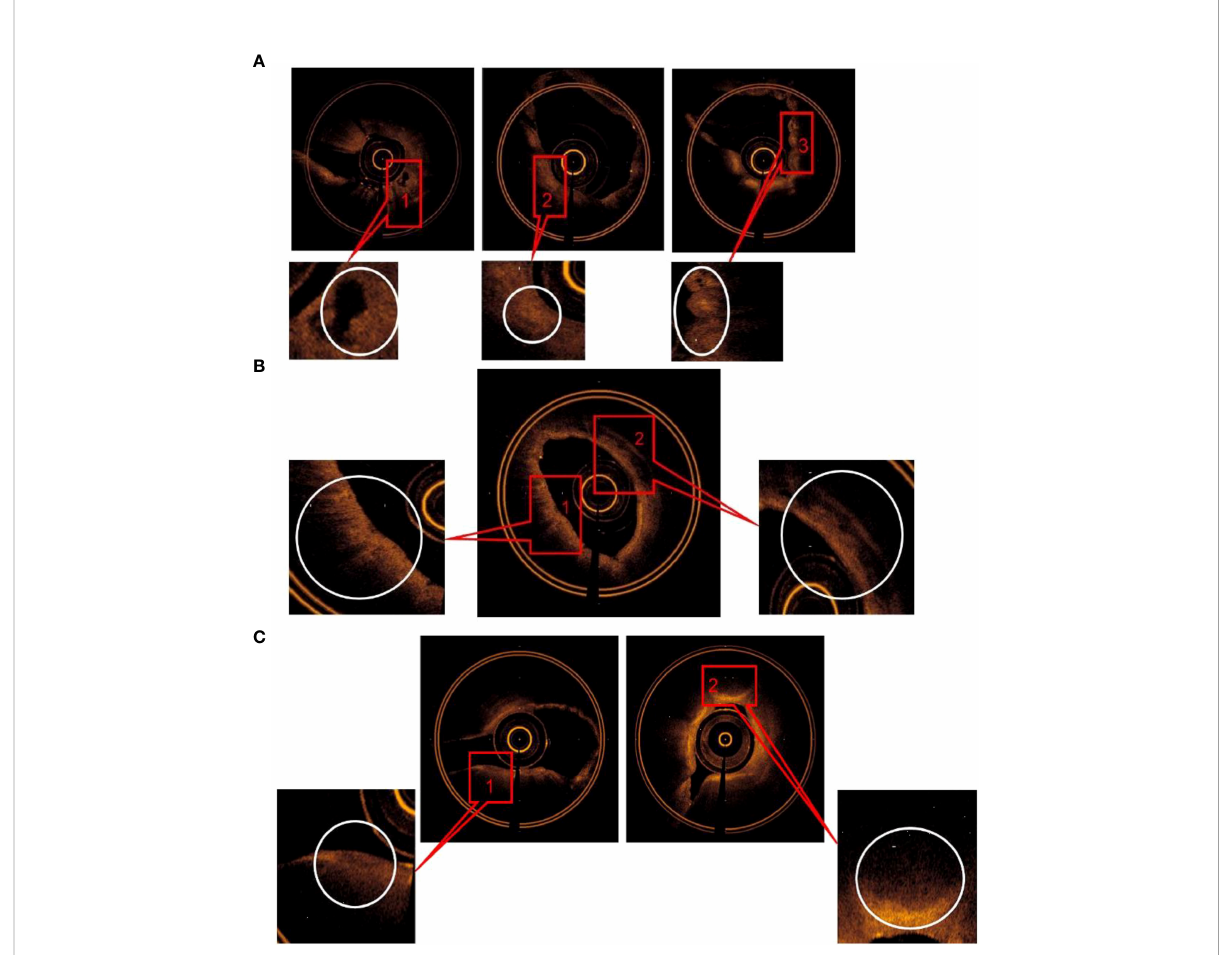
FIGURE 3 (A) The main OCT image features for predicting SCC: (1) “ Cyst-like ” structure, (2) “ round ” or irregularly shaped ” high signal nests, with or without low-density shadow, (3) Scaly protuberance of the epithelial layer, and a darkened gray level of the submucosa layer was found. (B) The main OCT image features for predicting adenocarcinoma: (1) “ Round ” or “ angulated ” poor signal structures was found in mucous layer, (2) continuous low density shadow was found in submucous layer. (C) The main OCT image features for predicting SCLC: (1)Low signal lines, which resembled “ fracture line ” , (2) a signi fi cantly thickened lamina propria with a darkened gray level of the submucosa layer w2as foundcontinuous low density shadow was